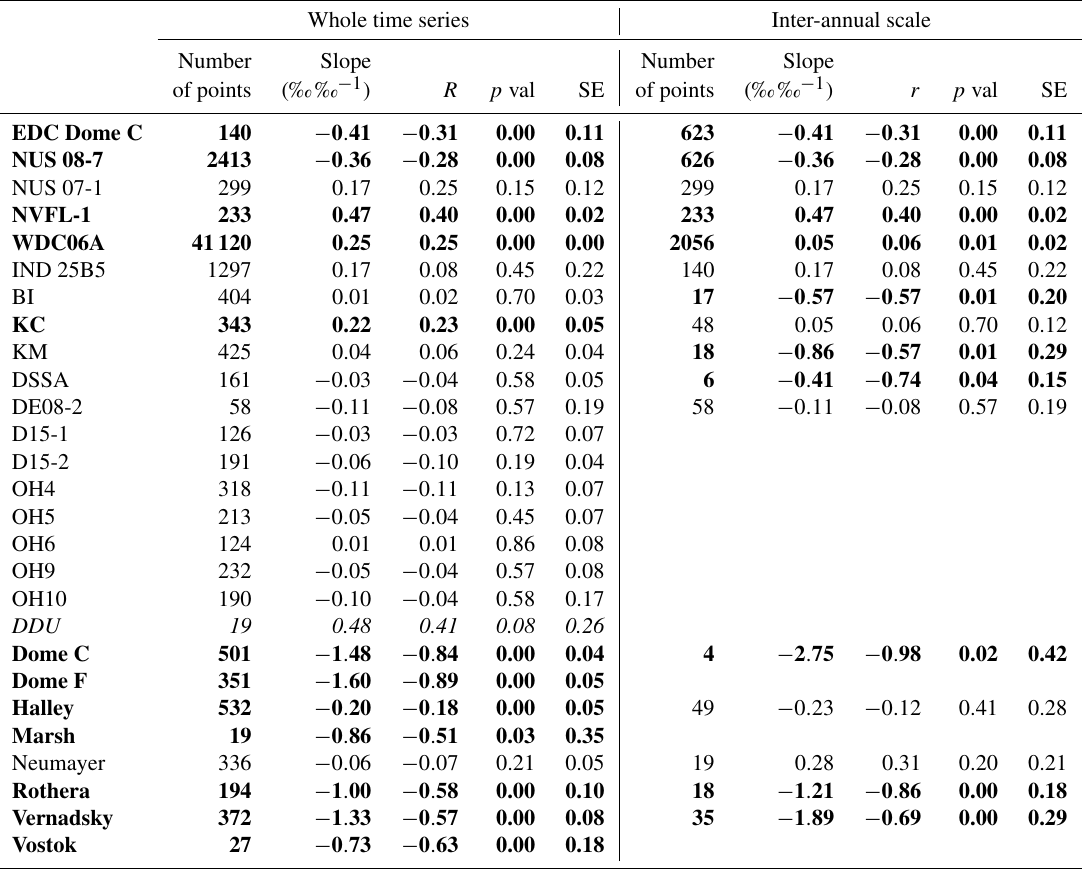
Table 5. The d -excess versus δ 18 O linear relationship of data from our database provided with d -excess over the whole time series (left side of the table) and over annual averages (inter-annual scale, right side of the table): slope (‰‰ − 1 ) , correlation coefficient ( r ), p value ( p val), and standard error of the slope (SE, ‰‰ − 1 ) . Cells in bold show a significant relationship ( p < 0 . 05) and the cell in italic is to be taken with caution (see DDU line, p < 0 . 10). Inter-annual relationships could not be computed for undated data (D15 and OH ice cores) or for precipitation data monitored for too short of a time and thus appear as empty